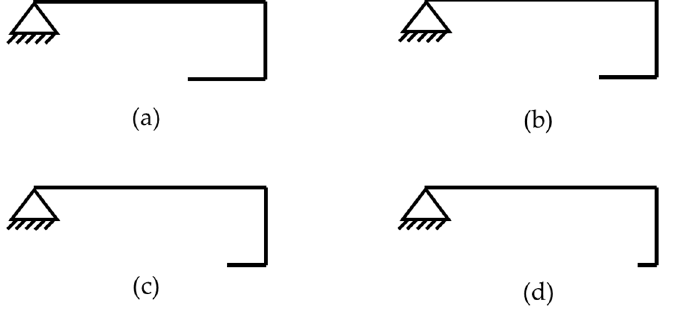
Figure 7. Complex edge stiffeners with different proportions: ( a ) a 2 : a 1 = 1; ( b ) a 2 : a 1 = 0.75; ( c ) a 2 : a 1 = 0.5; ( d ) a 2 : a 1 = 0.25.